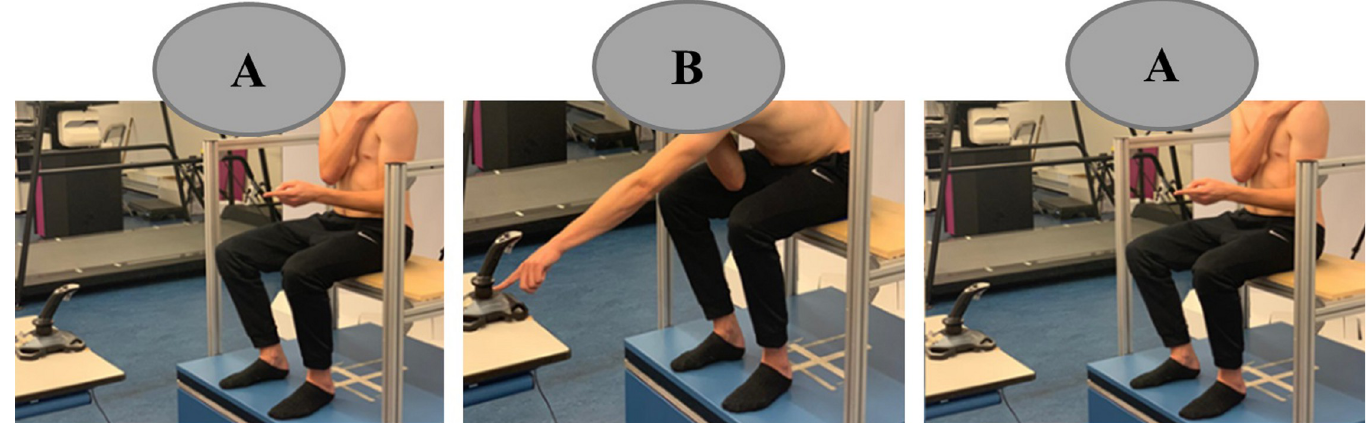
Fig 2. Overview of the task performed by the participants. Starting position–upright sitting (A), forward reaching to a distance of 1.25 x length of the upper limb to reach the target (B), and starting position again (A).